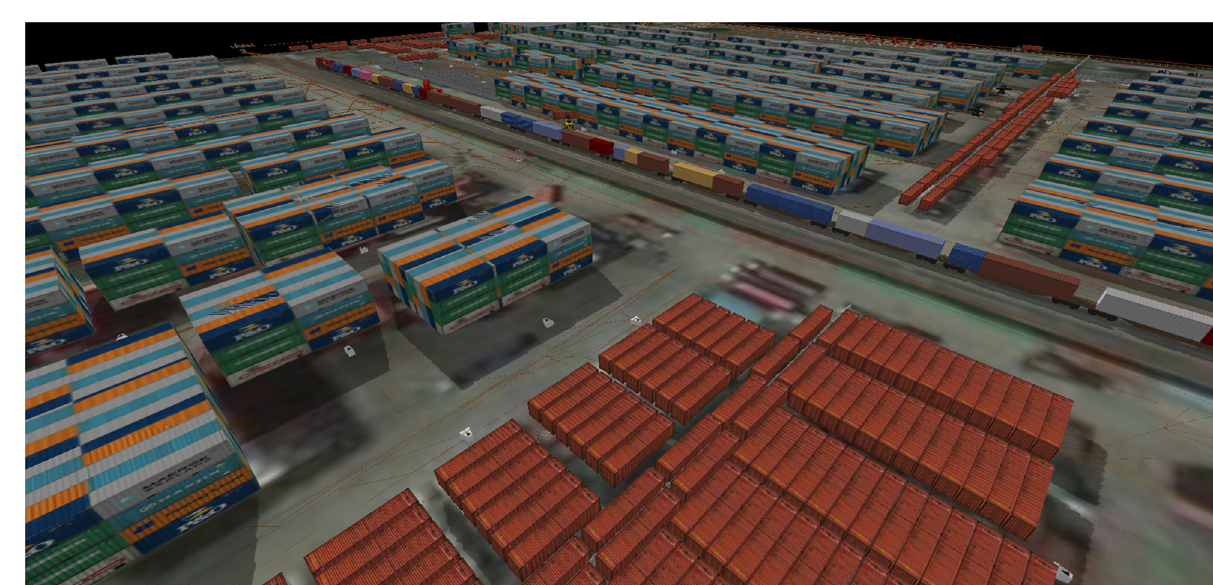
Fig 7. Rail area of a DES model representing the current LICD layout with no RTGs.